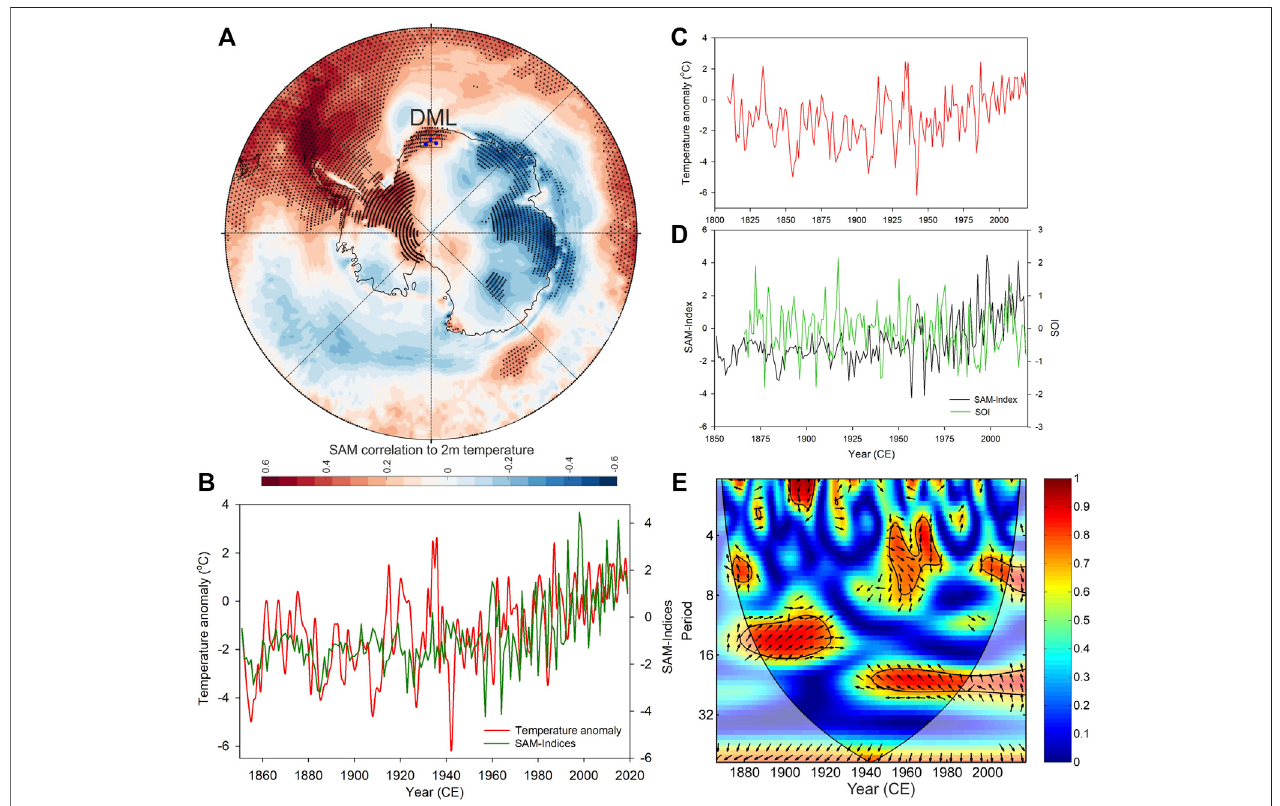
FIGURE 10 | (A) Spatial correlation of Marshall SAM index (Marshall, 2003) with ERA5 reanalysis surface air temperature during (1957 – 2019 CE). Stippling indicates statistically signi fi cant correlations (95% con fi dence level). (B) The Marshall SAM index combined with the long-term 20CRV2c SAM record (Gong and Wang, 1999) is compared with the DML temperature anomaly record. The reconstructed DML temperature anomaly record broadly follows the combined SAM records during their respective time intervals. (C) Annual reconstructed temperature anomaly record (1809 – 1993 CE) is combined with ERA5 reanalysis surface temperature (1994 – 2019 CE). (D) The combined SAM Index record is compared with the SOI record (Ropelewski and Jones, 1987). (E) Wavelet coherence between the combined SAM record and SOI record (1851 – 2019 CE). The black contours indicate 95% of con fi dence, based on a red noise model. The thick black line indicates the cone of in fl uence. The relative phase relationship is shown as arrows (with in-phase pointing right, antiphase pointing left, SAM leading SOI 90 ° pointing straight up, and vice versa).